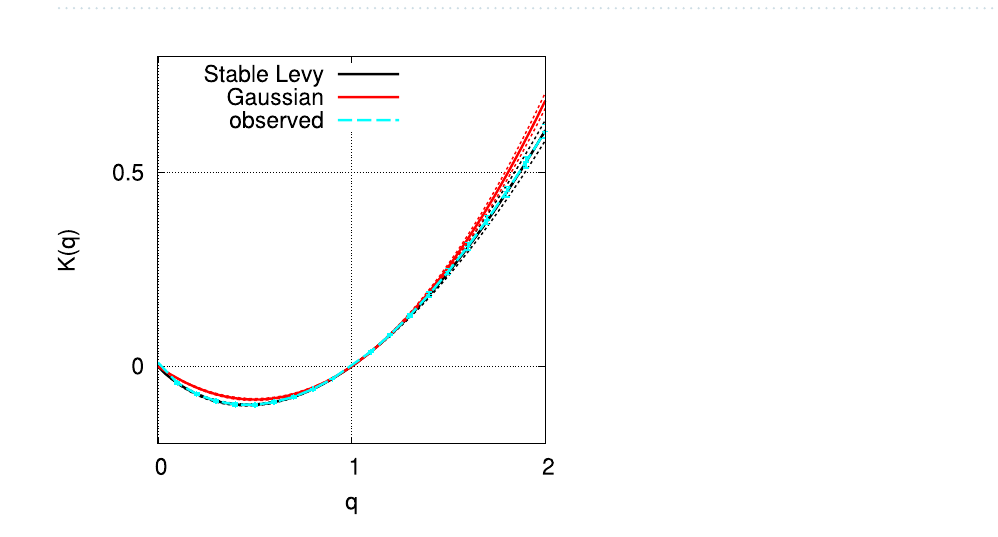
Figure 4. Scale dependency of the moments, is the width of the observational bin. The moment scaling exponents are found to be K ( 0.5 ) = − 0.099 ± 0.003, K ( 1.5 ) = 0.245 ± 0.007, K ( 2.0 ) = 0.606 ± 0.017 .